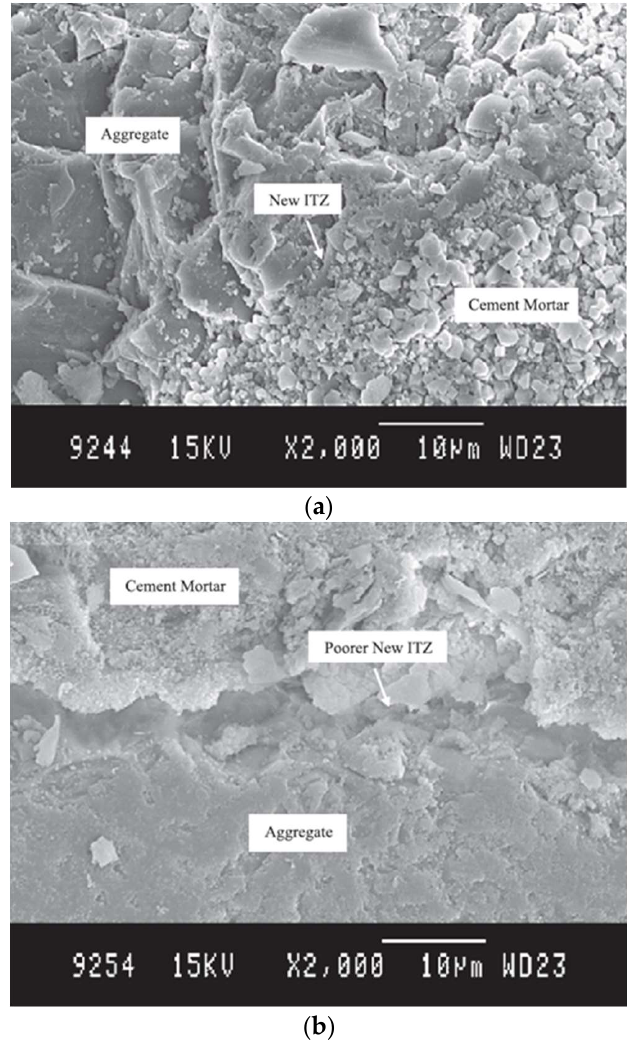
Figure 11. SEM images of new ITZ after ( a ) TSMA; ( b ) normal mixing [42]. Reproduced with per- mission from [42], Elsevier, 2005.